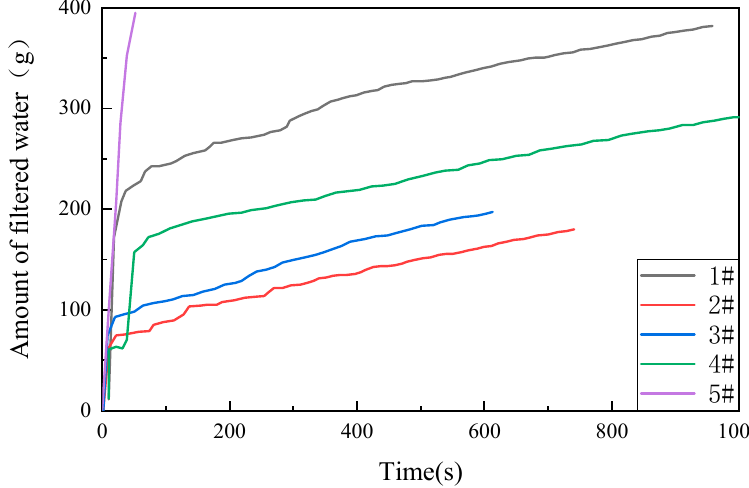
Figure 5. Mud intrusion into the formation in stratum G2. ( a ) 3# mud Intrusion Formation; ( b ) 5# mud Intrusion Formation.